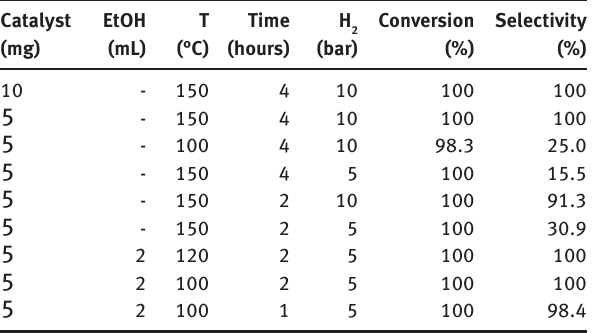
Table 5: Hydrogenation of commercial squalene. Catalyst